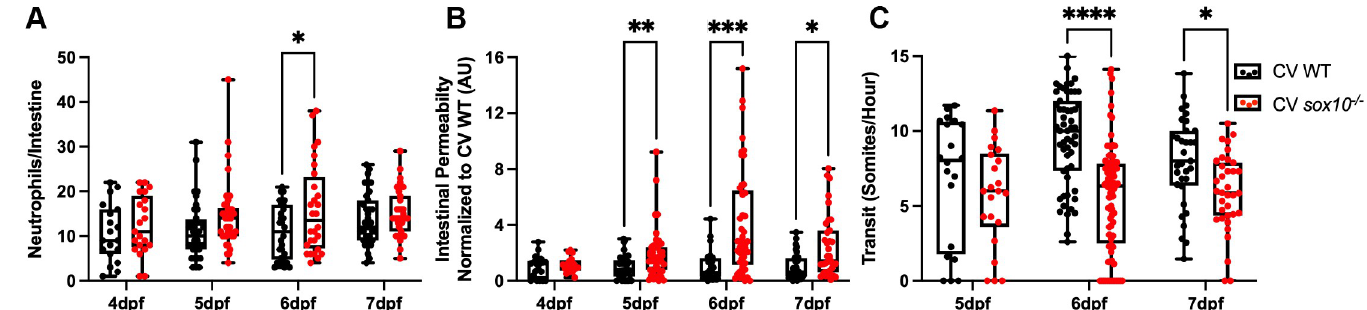
Fig 2. Hyperpermeability in CV sox10 mutants precedes decreased transit and microbial induced inflammation. (A) Quantification of intestinal neutrophil response. (B) FD4 permeability as measured by fluorescence intensity in aorta. (C) Transit at 4, 5, 6, and 7 dpf. Each dot is a fish; n > 18 for each condition. Boxes represent the first to third quartiles, center bar denotes the median, and whiskers the maximum and minimum of each dataset. � p < 0.05, �� p < 0.01, ���� p < 00001. A&C: Two-way ANOVA followed by Sˇı´da´k multiple comparisons test; B: Kolmogorov-Smirnov non-parametric t-test.